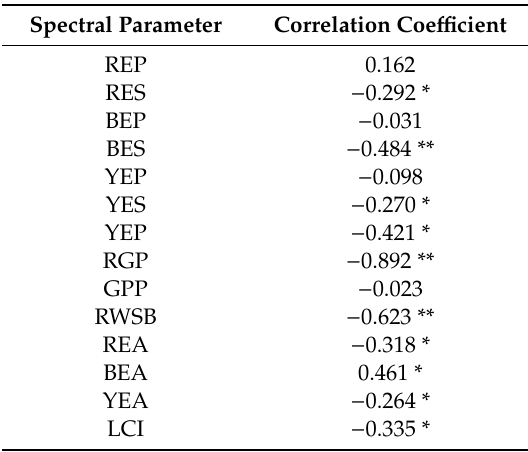
Table 2. Relationships between chlorophyll content index and spectral feature parameters. * indicates that the correlation reaches a significant level at the level of 0.05, ** indicates that it is extremely significant at the level of 0.01. The number of samples n =